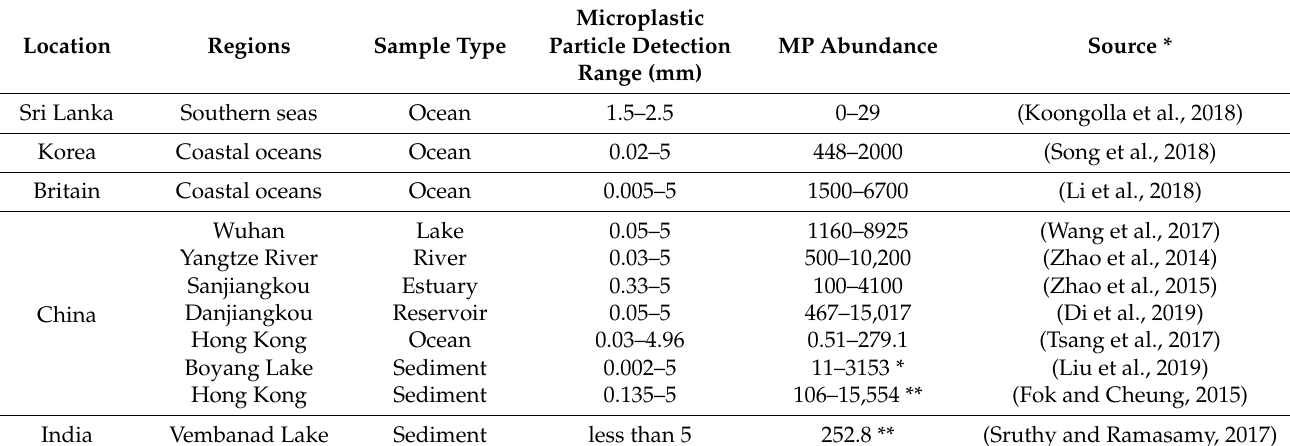
Table 2. Current status of domestic and international MPs pollution in different regions.